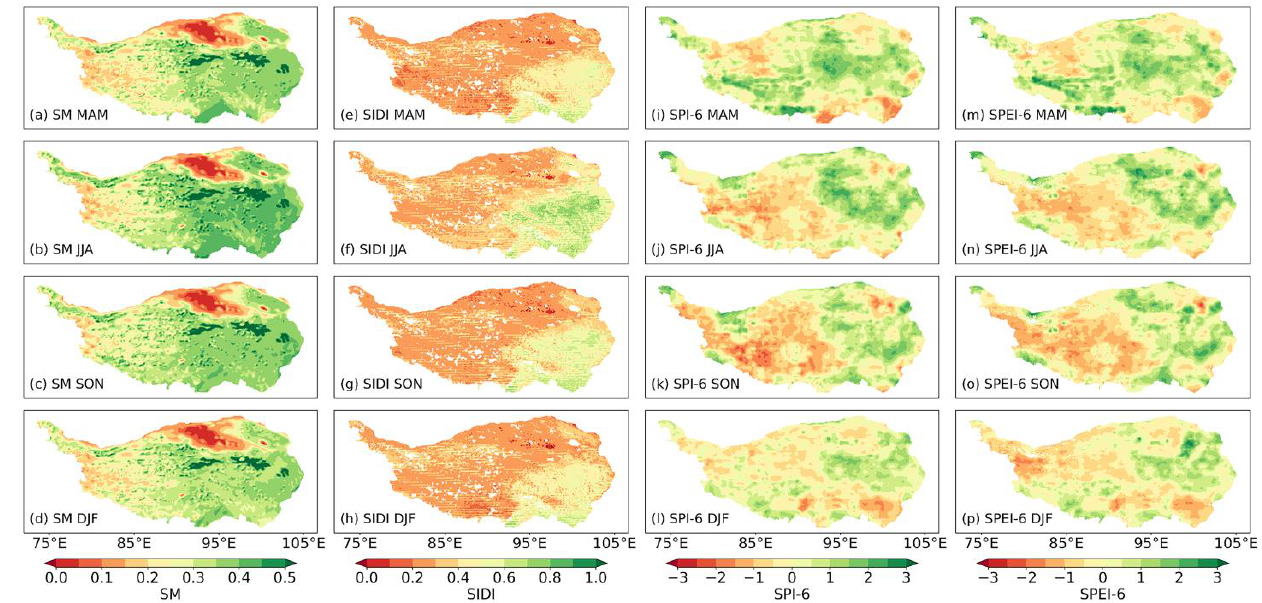
Figure 5. Comparisons of spatial and seasonal distributions of SIDI ( e – h ) against ERA5-Land SM at 7 – 28 cm (( a – d ), units: m 3 /m 3 ), SPI-6 ( i – l ), and SPEI-6 ( m – p ) in 2012. Colors represent drought degree: the redder the color, the stronger the drought degree is.